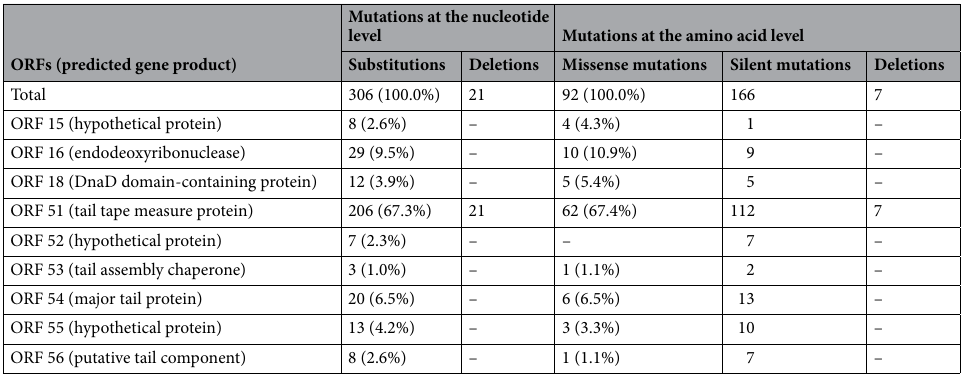
Table 1. The number of mutations in the mutant phage SA3821 M .